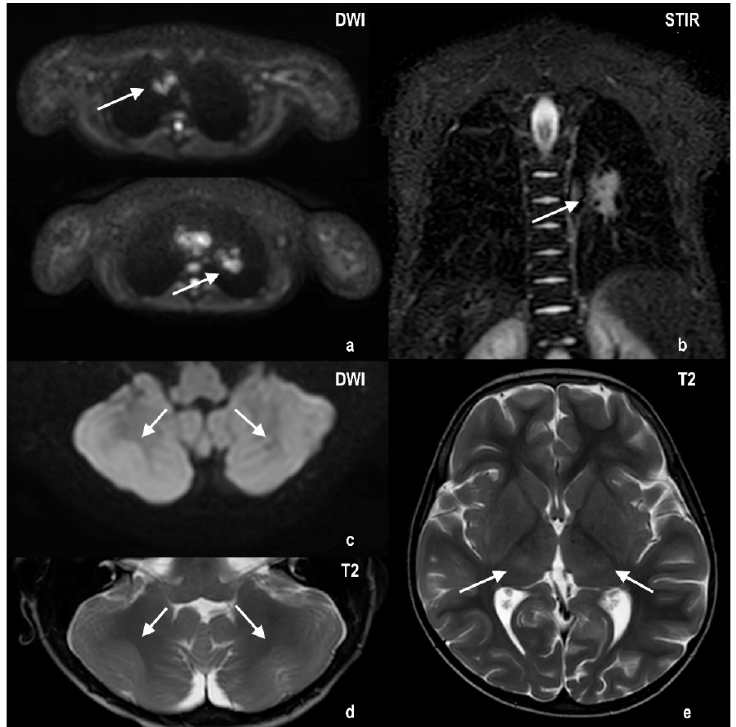
Figure 1. Thoracic MRI shows DWI restriction areas corresponding to the right paratracheal lymph node chains, associated with a left peribronchial area presenting a similar aspect (panel ( a ): axial DWI; panel ( b ): coronal STIR). Cerebral MRI shows bilateral symmetric cerebellar cortex swelling and T2 hyperintensity, with DWI (b1000). Restricted diffusion from cytotoxic vasogenic edema can be seen (panels ( c , d ): cerebellar DWI and T2, respectively), along with T2 hyperintensity of posterior thalami (panel ( e ): axial